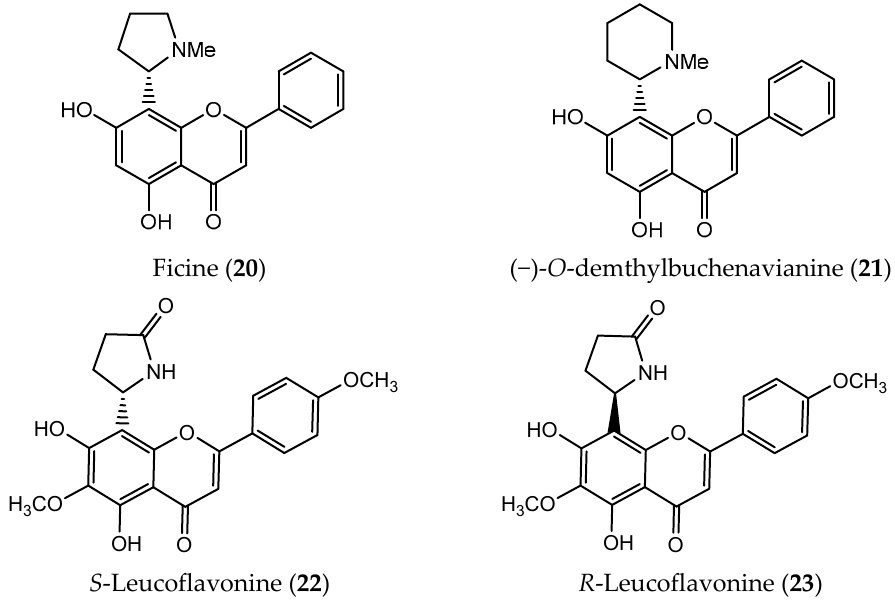
Figure 6. Natural flavoalkaloids with reported antitumor activity. In 2012 it was found that natural compounds having a flavoalkaloid skeleton were bark and roots of Daphne giraldii , including four pairs of enantiomers and two pairs of potent CDK inhibitors, particularly those with S configuration and a piperidine or a epimers. The isolation was performed by liquid chromatography (LC) with a Chiralpak pyrrolidine group in position 8 [104]. Ficine ( 20 , Figure 6), a flavoalkaloid with a pyrrolidine moiety, isolated from Ficus pantoniana has proven to be a great inhibitor of CDK1 and CDK5, AD-H column in reversed elution mode. Daphnegiralin A 4 ( 24 ) and daphnegiralins B 1 -B 4 with an IC 50 value of 0.04 µ M against both isoforms ( 25–28 ,Figure 7) showed in vitro growth inhibitory activity in liver cancer Hep3B cell line, with IC 50 values below 10 µM [107].